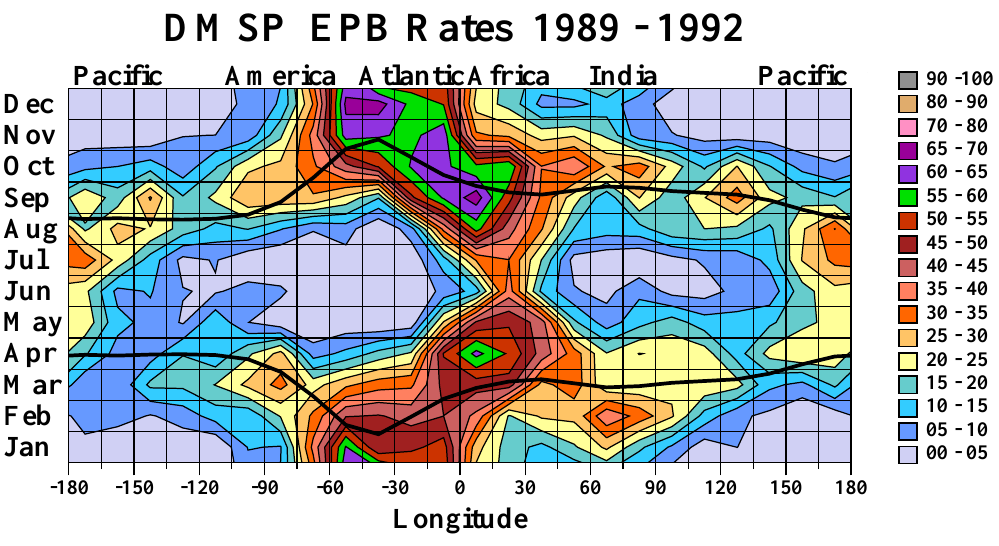
Fig. 4. Contour plot of EPB rates for solar maximum 1989–1992 in the same format as Fig. 3. EPBs occurred throughout the year in the Atlantic-Africa sector; rates were > 60% in January, April, and September to December.